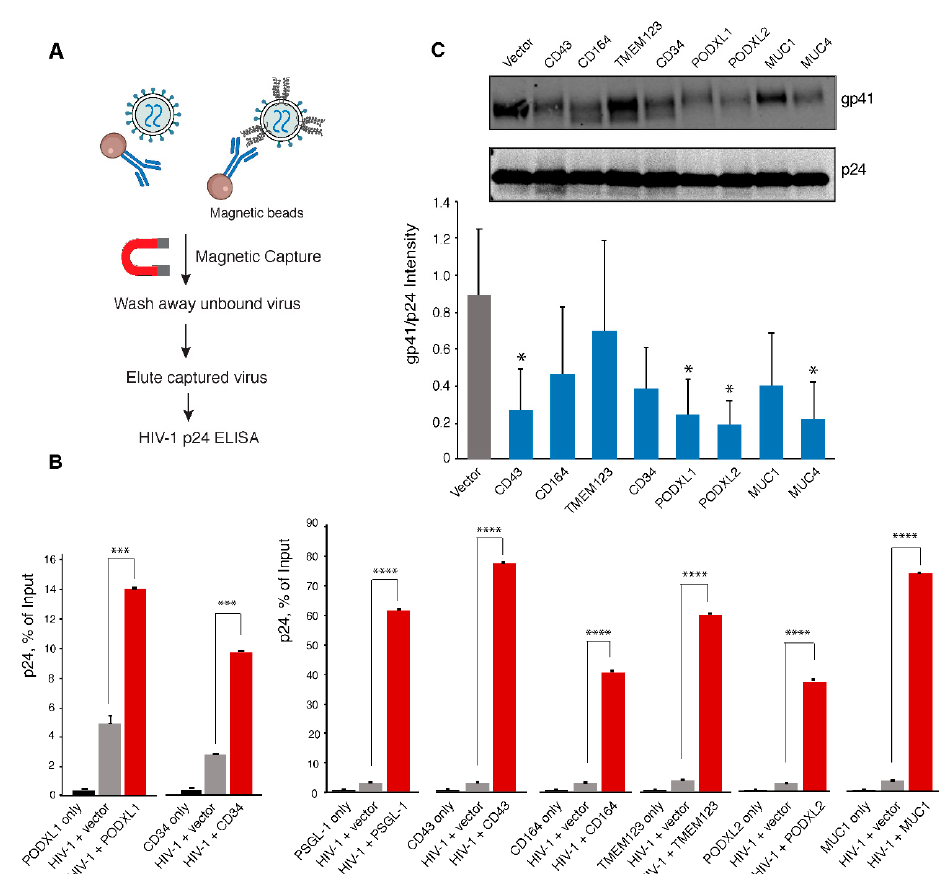
Figure 4. Virion incorporation of SHREK proteins and its effects on HIV-1 Env incorporation. ( A ) Schematic of the immune-magnetic capture assay used to detect SHREK proteins on HIV-1 particles. ( B ) HEK293T cells were cotransfected with pHIV-1(NL4-3) DNA (1 µg) plus each individual SHREK protein expression vector or empty vector (400 ng of DNA). As a control, cells were also transfected with only SHREK-expressing vector (400 ng). Empty vector was used to maintain an equal DNA concentration. For MUC1 and TMEM123, vectors expressing hemagglutinin-tagged TMEM123 or MUC1 were used. Supernatants were harvested at 48 h, normalized for p24, and incubated with magnetic beads coated with antibodies for each individual SHREK or hemagglutinin. Captured particles were washed, eluted, and quantified for the p24 levels with HIV-1 p24 ELISA. Data are presented as the percentage of input particles captured by the beads. The experiment was independently repeated 3 times, and the means ± SD from experiment triplicate are shown. ( C ) Effect of SHREK proteins on HIV-1 Env incorporation. HEK293T cells were cotransfected with HIV(NL4-3) DNA plus each individual SHREK protein expression vector or an empty vector. Particles were harvested at 48 h, and purified through a sucrose gradient. Virions were lysed and analyzed with Western blot using antibodies against HIV-1 gp41 and p24. Representative blots from 3 independent experiment repeats are shown. The band intensities were quantified from the three blots and normalized for p24. p -values were calculated using the two-tailed T-test. Significance values are indicated using asterisks as follows; * = p < 0.05, *** = p < 0.001, **** = p < 0.0001.